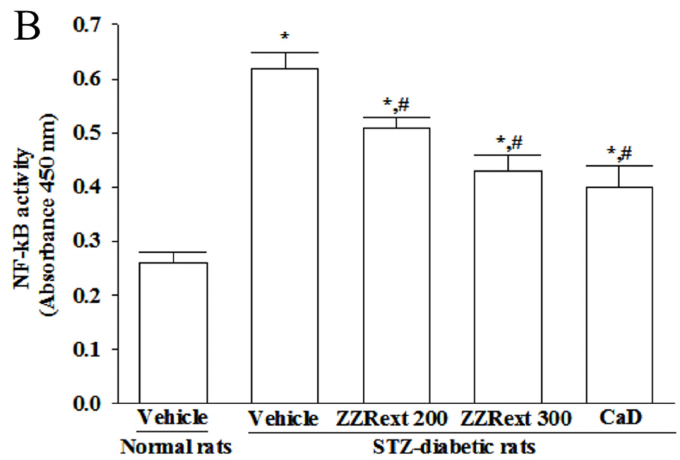
Figure 4. Effects of the treatments on diabetes induced retinal p38 MAPK and NF- 